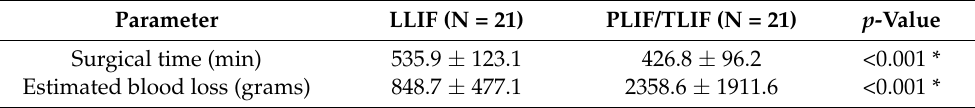
Table 2. Surgical invasion in the LLIF group and the PLIF/TLIF group.